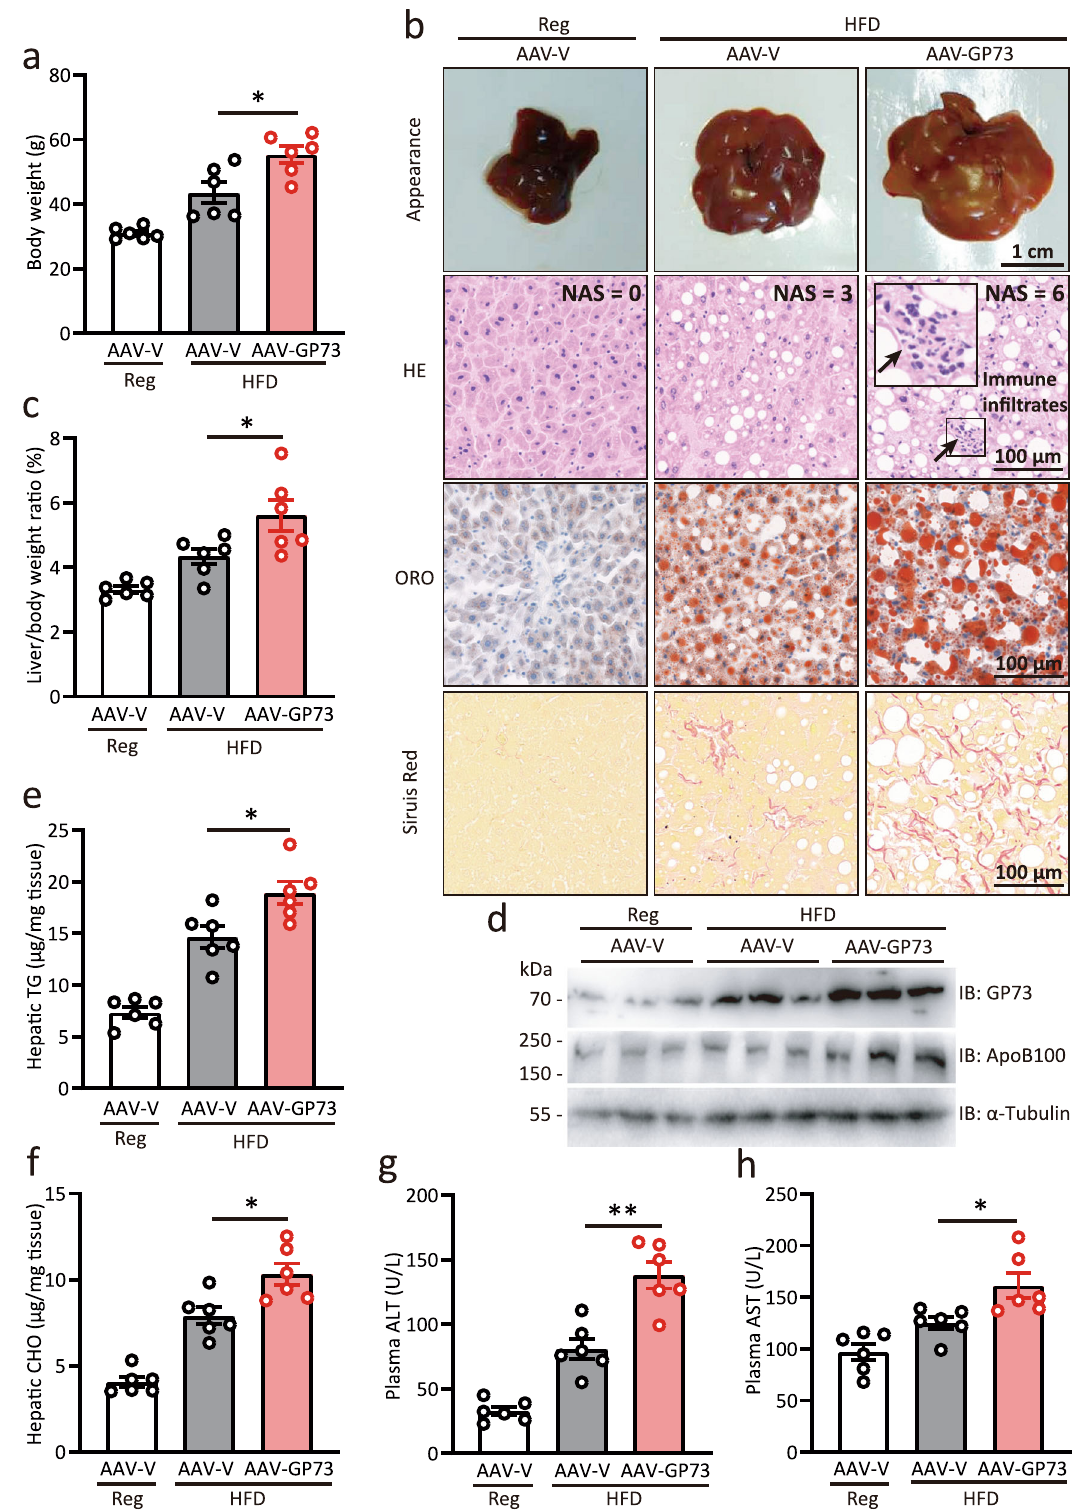
(Fig. 8b – h). The fi nal body weight and inguinal white adipose tissue (WAT)-to-body weight ratio were unaffected (Fig. 8i, j). Of note, siGP73 administration alleviated liver damage and caused signi fi cant decreases in blood glucose levels (Fig. 8e – g). In the intervention protocol, knockdown of liver-GP73 also improved insulin sensitivity (Fig. 8h). In particular, hepatocyte TG and CHO levels were lower in the siGP73-treated group than in the control